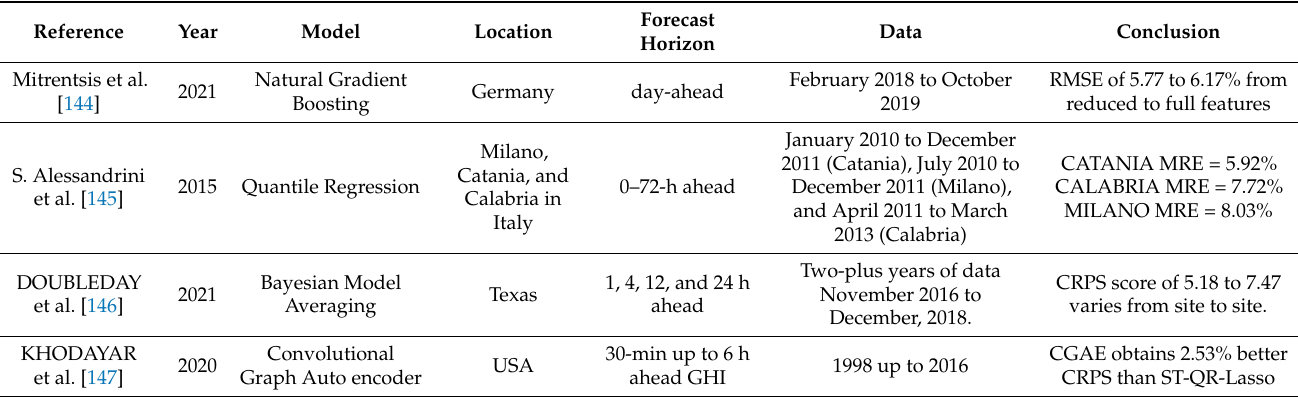
Table 9. Summary of probabilistic